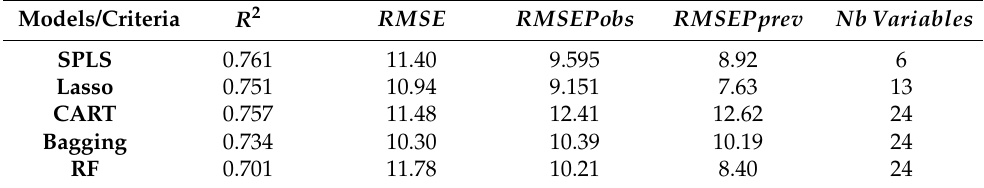
Table A2. Comparison table of parametric and nonparametric models according to the R 2 , RMSE , RMSEPobs , RMSEPprev , and Nb Varibales criteria.